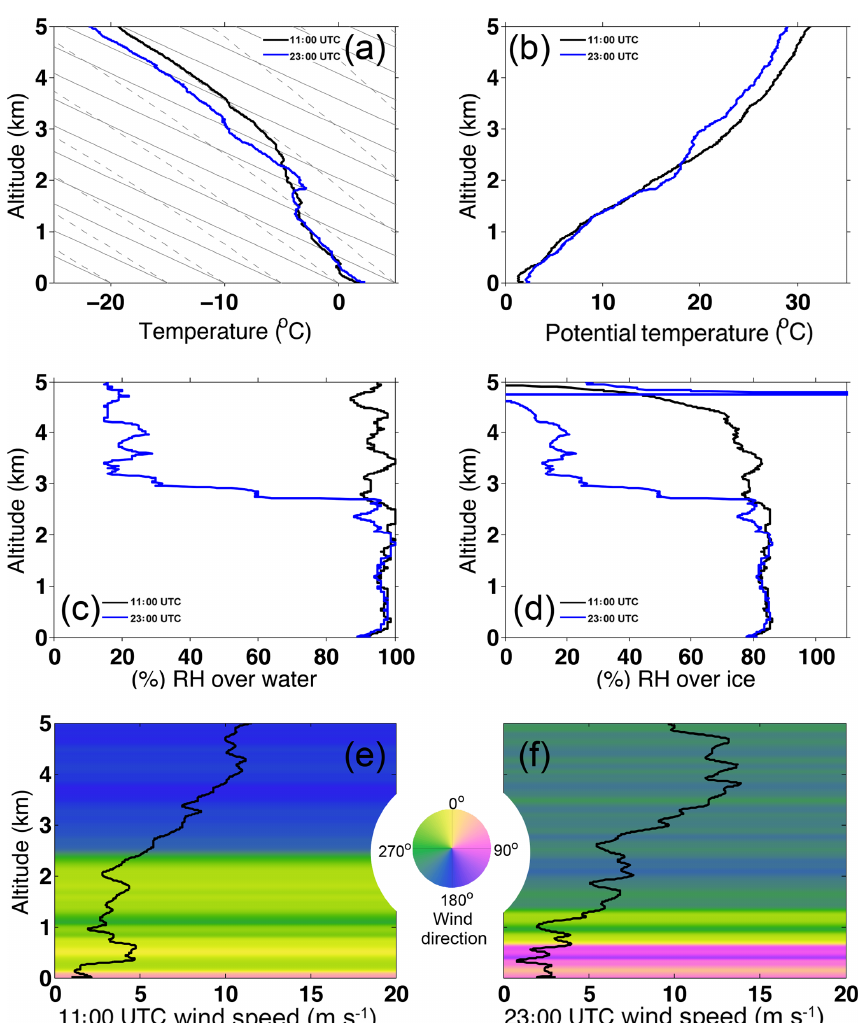
Figure C2. 26 August 2017. From the two daily radiosondes launched by the Eureka Weather Station; panel (a) is the temperature, grey solid lines are dry adiabats, and grey dashed lines are moist adiabats. Panel (b) is the potential temperature. Panels (c, d) are the relative humidity with respect to water and ice, respectively. Panels (e, f) are the wind speed (black line) and direction (coloured